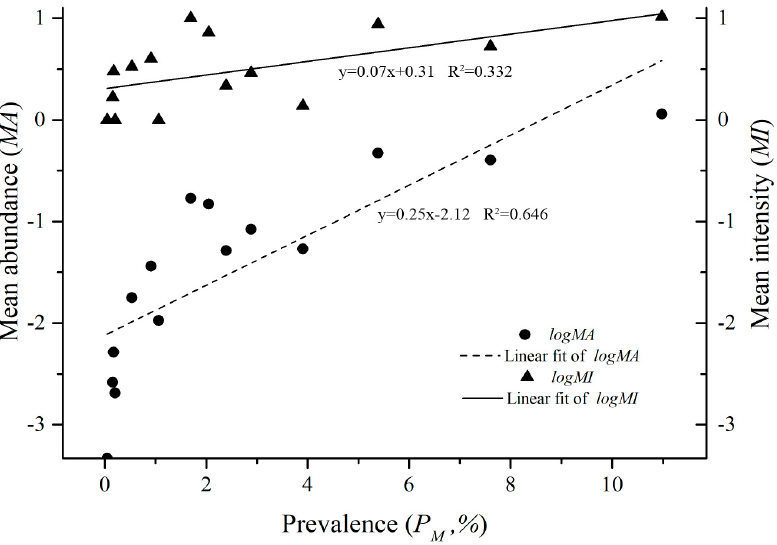
Figure 2. The linear regression between P M , MA and MI of 15 host species with O. bacoti mites in Yunnan Province, Southwest China (1990–2015).